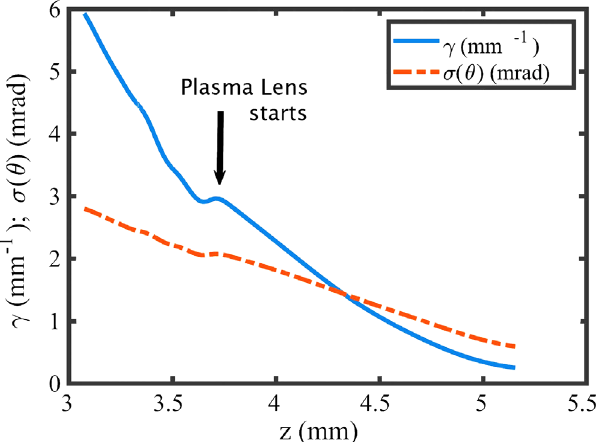
FIG. 8. Evolution of the Twiss γ parameter (blue line) and of the beam divergence (dashed orange line), starting from the end of the plateau. Plasma lens starts approximately at z ¼ 3 . 7 mm. The minimum Twiss γ parameter is γ ¼ 0 . 14 mm − 1 .